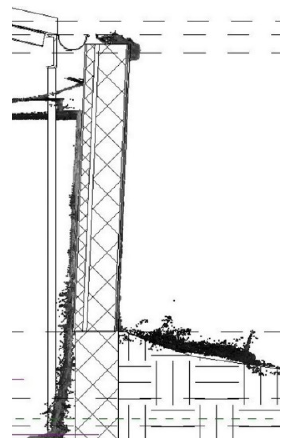
Figure 8: detail of the connection between the canopy and the existing structure.